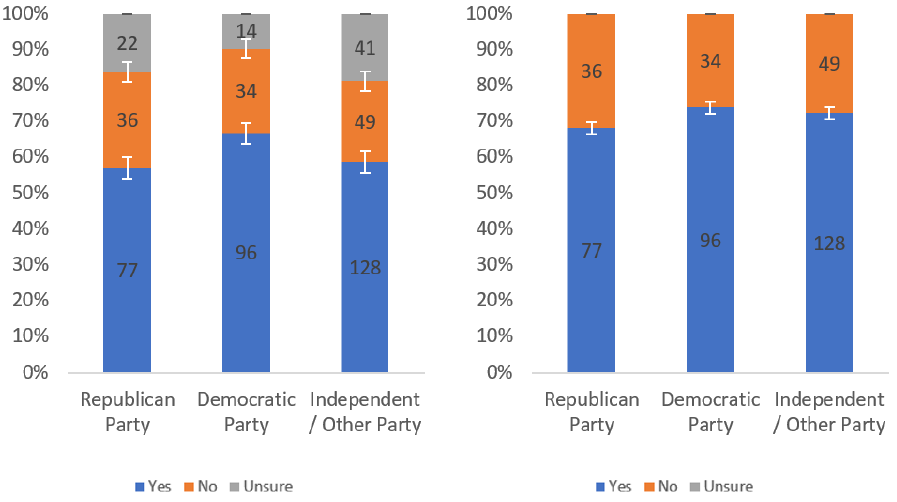
Figure 20. Responses regarding usefulness in judging trustworthiness by party affiliation including ( left ) and excluding ( right ) unsure responses.